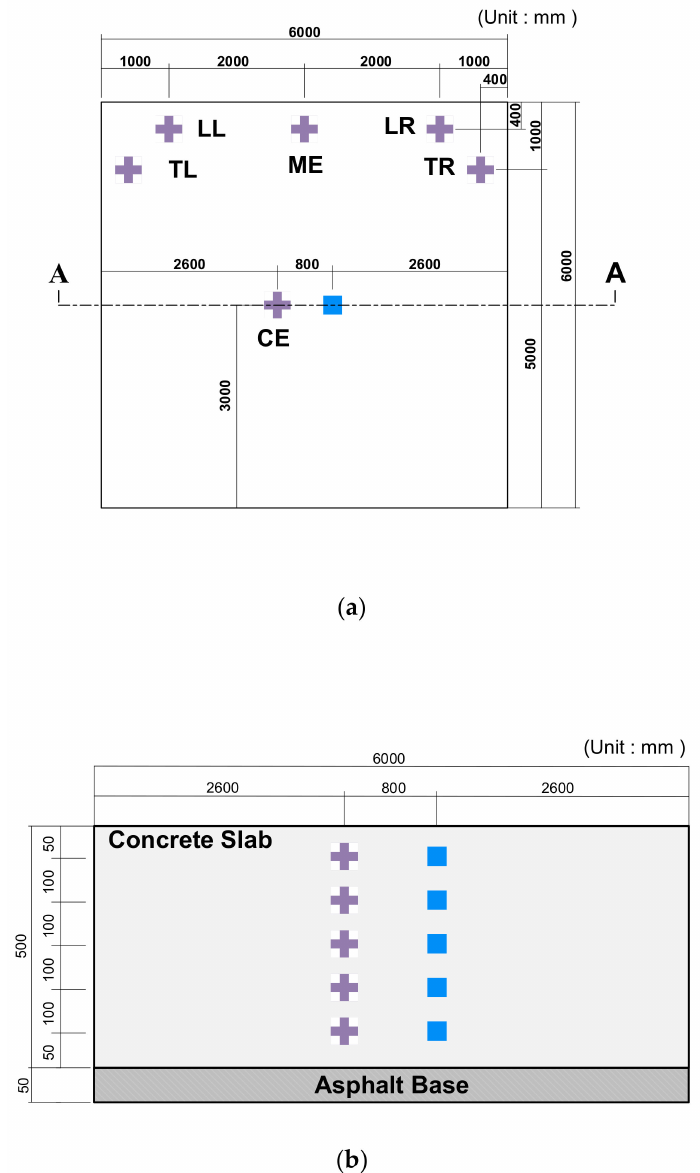
Figure 3. Positions of gauges in the slabs of zone A: ( a ) plane and ( b ) section